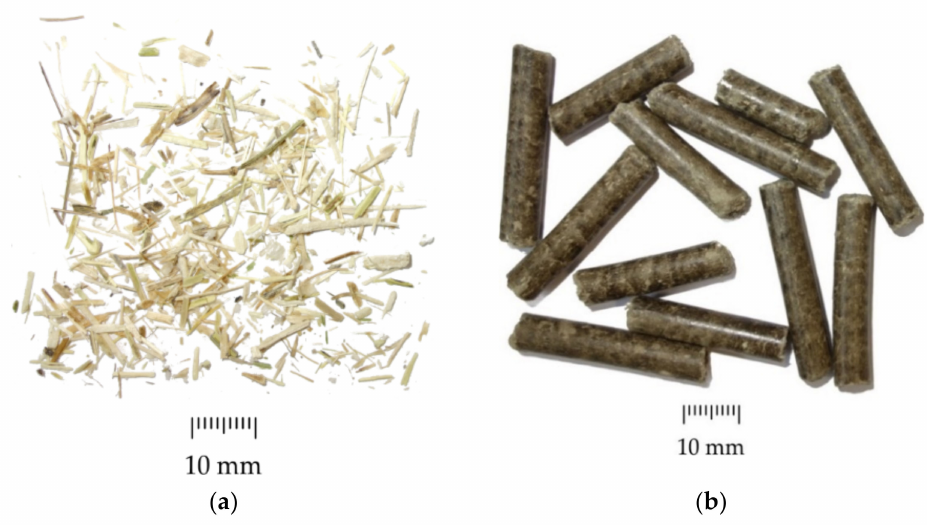
Figure 2. Biomass samples: ( a ) comminuted rape straw; ( b ) rape straw pellets. The hot pellets coming out of the pelletizing press are fed directly to the inlet of the spiral vibrating trough. A spiral vibrating feeder was used to cool oilseed rape straw pellets. The cooling itself takes place during the transport of the pellets on the spiral trough of the vibrating feeder. The vibrating spiral trough causes the pellets to move upwards in a spiral due to micro-motions. The heat from the hot pellets is dissipated to the environment. The cooling efficiency of the hot pellets depends on the setting of the operating conditions of the spiral vibrating feeder and its construction. With a pair of vibromotors running, the vibrating unit produces a motion that consists of the amplitude of a rectilinear oscillating displacement ( A z , m) in the direction of the Z axis and an oscillating angular rotation ( ϕ ’, ◦ ) around the Z axis (see Figure 3). Combining these two movements creates